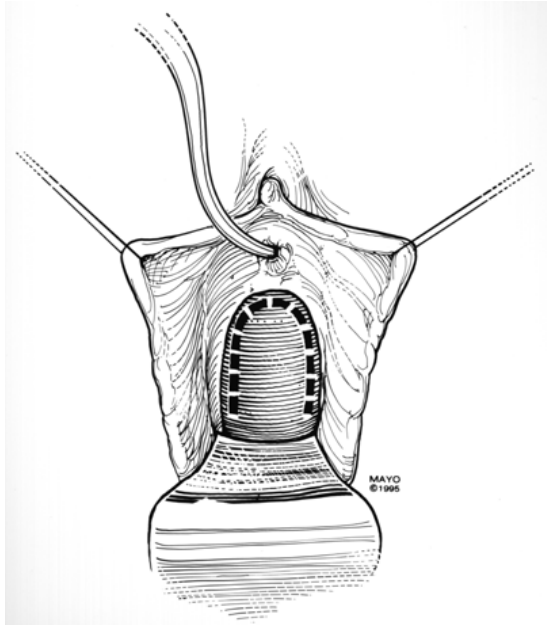
FIGURE 11. Site of anterior vaginal wall incision for transvaginal AUS